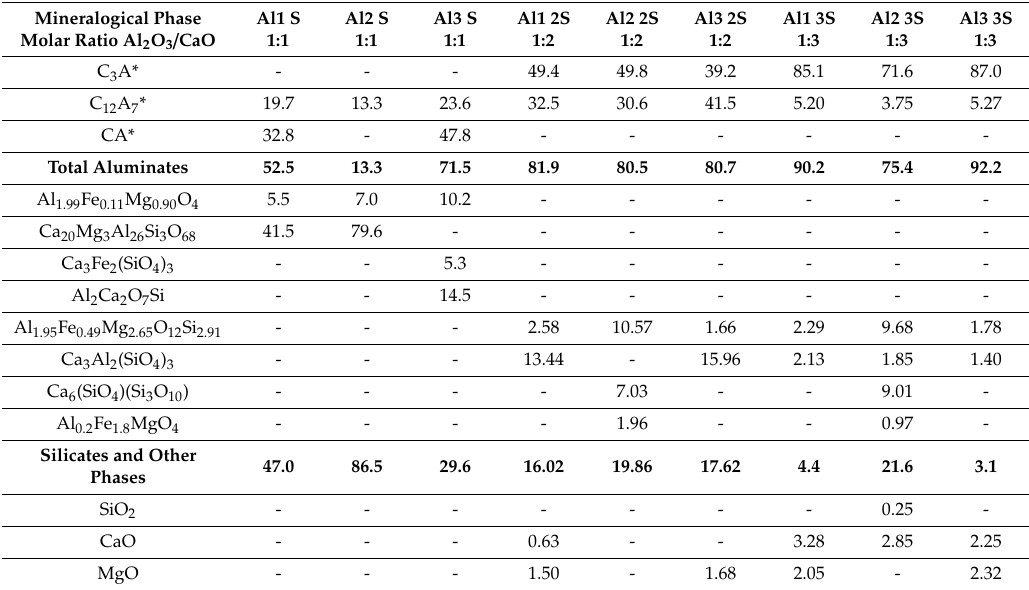
Table 4. Mineralogical composition of the sintered materials with each dross (wt %). Mineralogical Phase Molar Ratio Al 2 O 3 / CaO